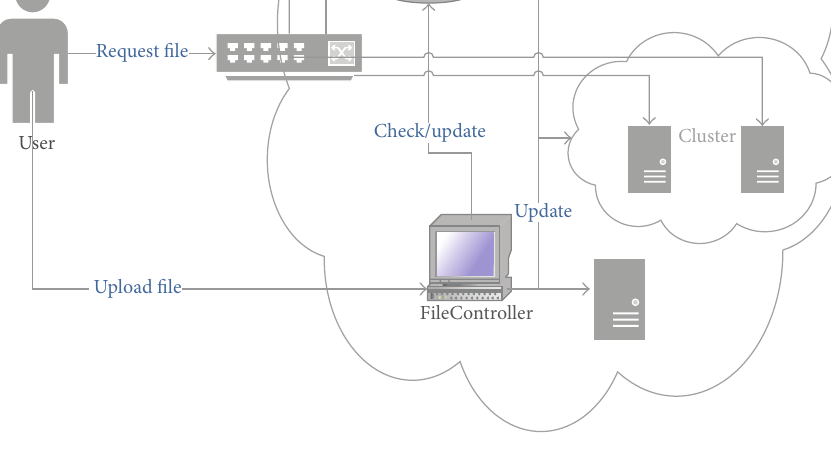
Figure 9: Solution